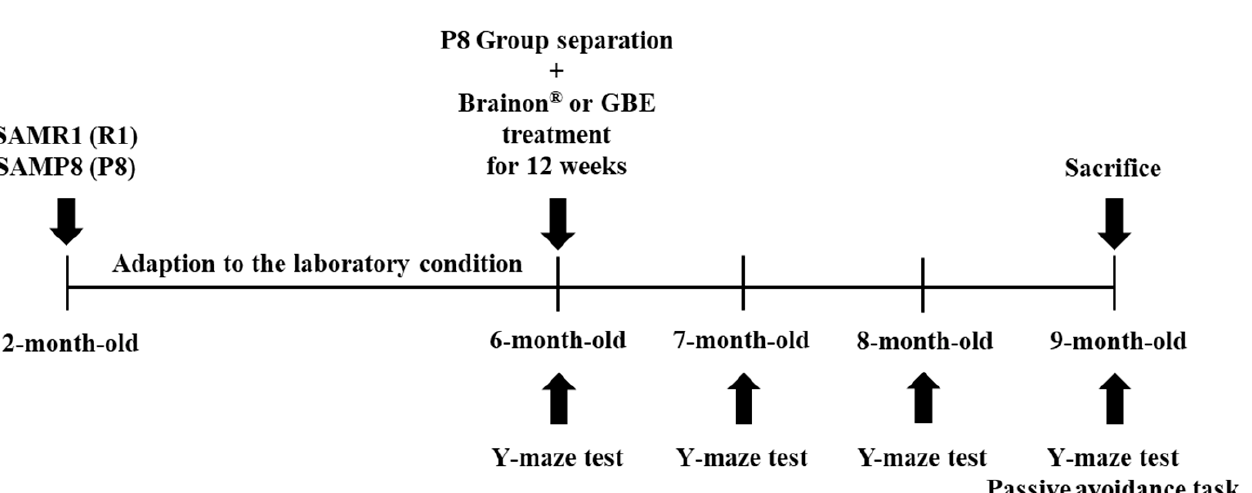
Figure 2. Schematic representation of the experimental design.